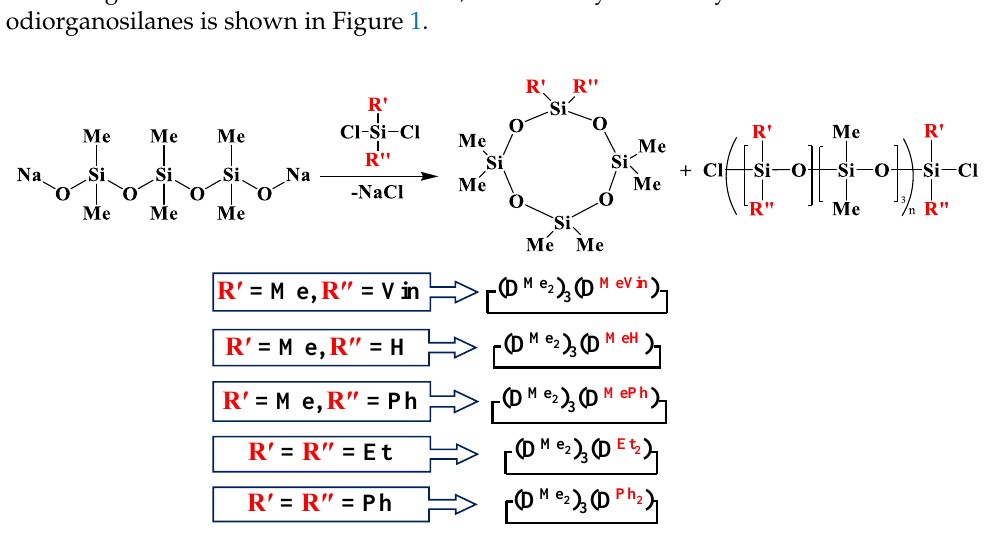
Figure 1. Scheme of interaction of 1,5-disodiumoxyhexamethyltrisiloxane and diorganodichlorosilanes.